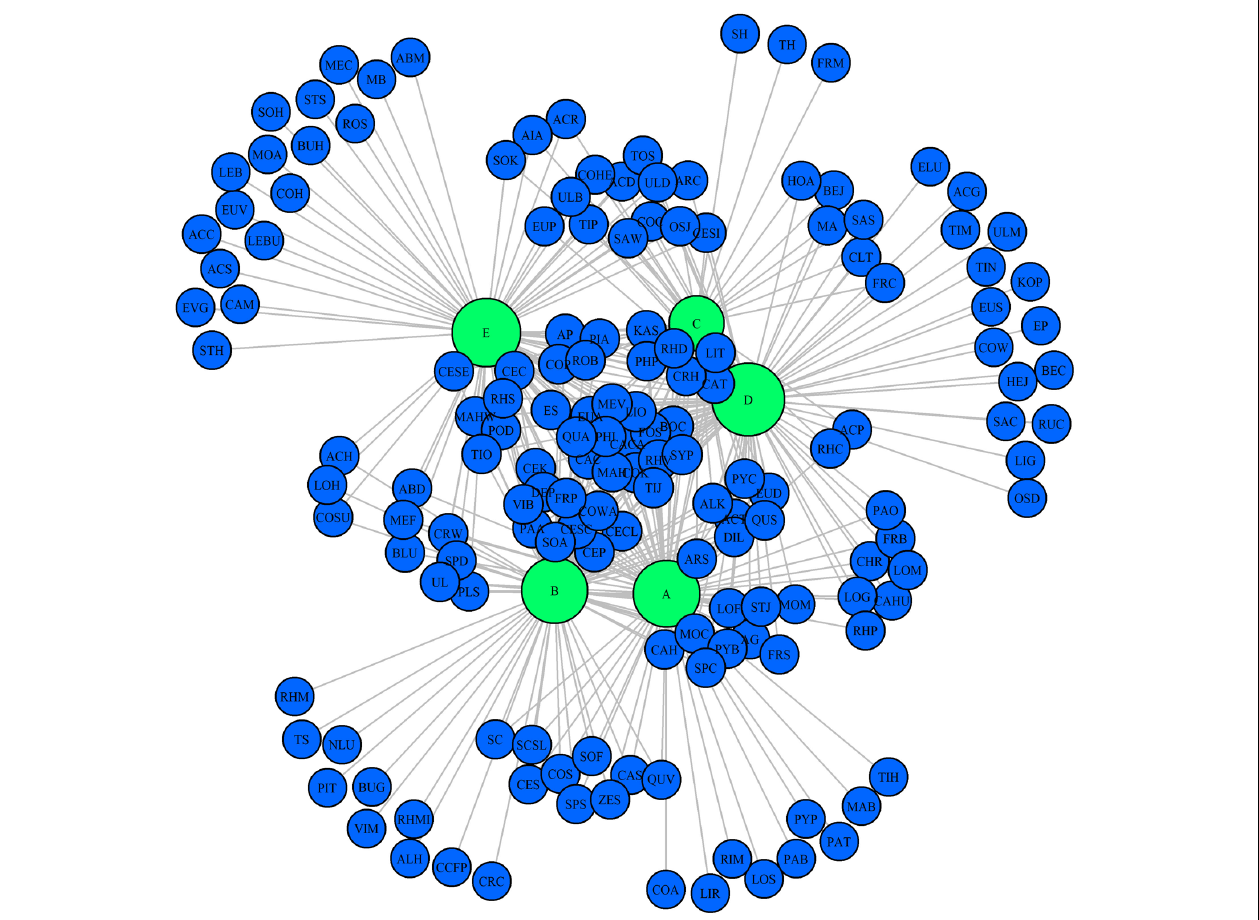
FIGURE 7 | Network analysis of species composition among the five communities. The size of the dot indicates the abundance of species. A, B, C, D, and E were the Quercus variabilis community, Quercus glandulifera var. brevipetiolata community, Mixed broadleaf-conifer community, Quercus aliena var. acutiserrata community, and Miscellaneous wood community, respectively. The abbreviations of species are shown in Supplementary Table S3 .